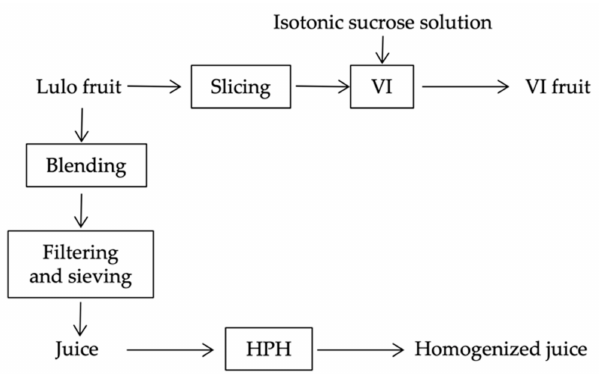
Figure 1. Flow chart summarizing sample preparation and